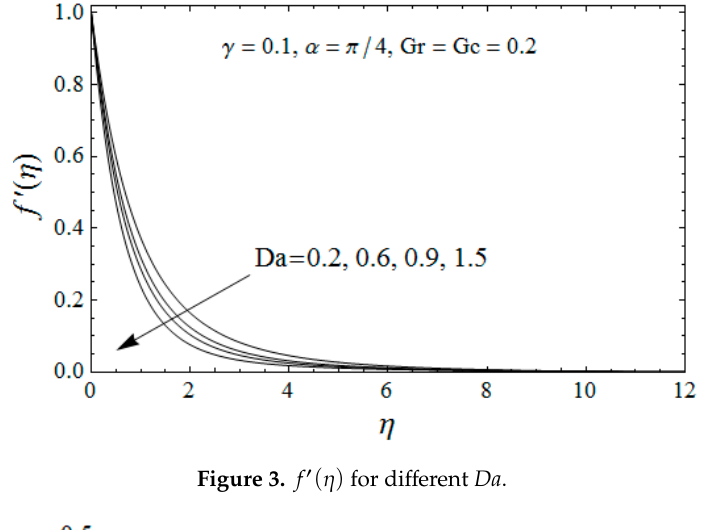
Figure 3. 𝑓′(𝜂) for different 𝐷𝑎. Figure 3. f (cid:48) ( η ) for di ff erent Da .